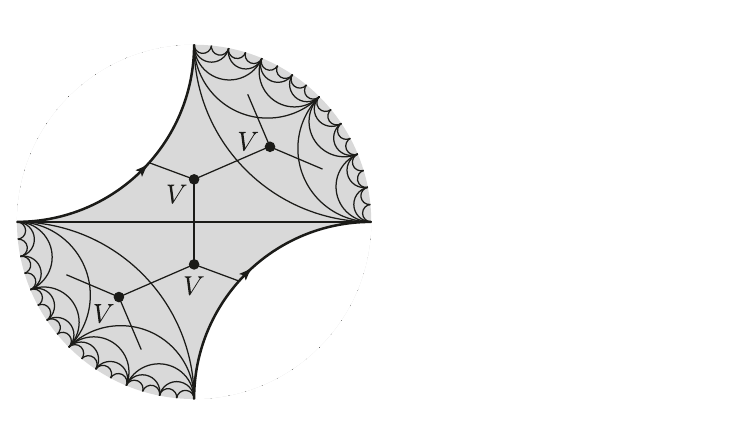
Figure 23 . A tensor network for the BTZ black